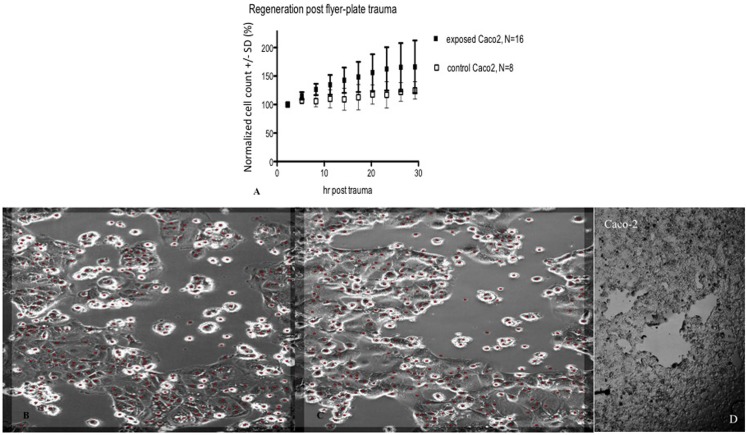
Cell count (normalized mean ± SD) in lesion peripheries vs. control-colonies of Caco-2, trauma exposures in (A). Micrographs of live Caco-2 – first (B) and last images post trauma illustrating growth at the lesion periphery (C). The red dots indicate counted cells. Original magnification 10×. Incubated, photographed, and counted by Cell-IQ. (D) shows microphotograph overview of injury to Caco-2 cells that typically resulted in multiple separated patches devoid of cells.